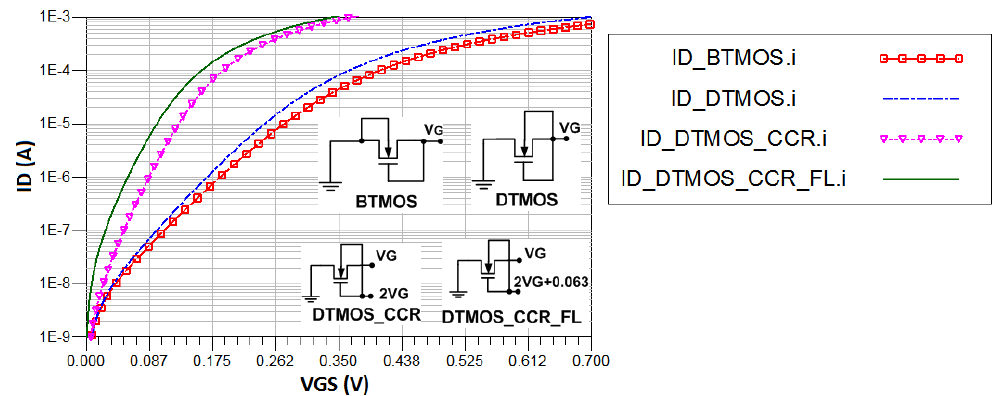
Figure 5. Simulated IV characteristic of the DTMOS diode, body-tide-to-source MOSFET (BTMOS) diode, DTMOS cross-coupled rectifier (CCR) configuration, and DTMOS CCR with floating sub-circuits